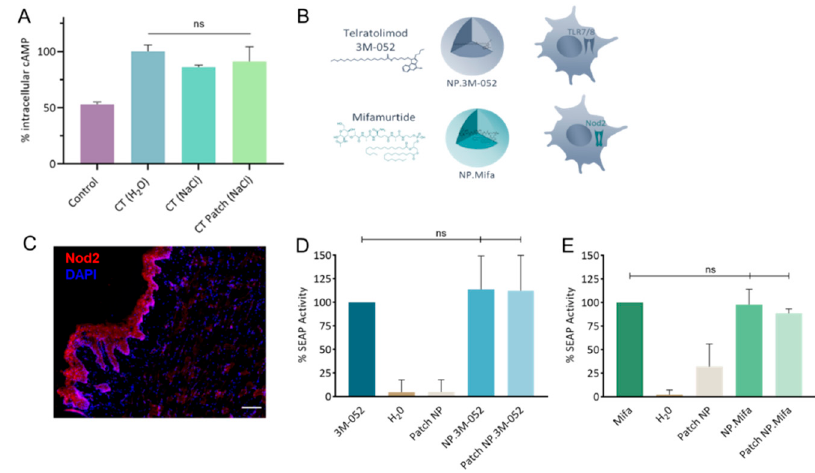
Figure 4. Bioactivity of mucosal adjuvants. ( A ) Quantification of intracellular cAMP produced after 24 h incubation of DC 2.4 cells with CT either formulated as a liquid solution (H 2 O or NaCl) or as an LbL patch in 0.15 mol/L NaCl. The percentage was normalized to the average amount of cAMP produced after contact with CT in H 2 O. ( B ) Schematics of 3M-052 and mifamurtide incorporated in PLA-NP and their respective immune receptors. ( C ) Staining of Nod2 receptors in the SL mucosa of mice. Nod2 receptors (red) and nuclei (DAPI, blue) were stained in naïve mice. Scale bar, 100 µ m. ( D , E ) Quantification of the SEAP produced after the activation of ( D ) HEK-Blue hTLR7 cells by 3M-052 formulations and ( E ) HEK-Blue hNOD2 cells by mifamurtide formulations, either in their free form, encapsulated in NP, or released from the LbL patch. Data are presented as mean ± SD and were statistically analyzed using one-way ANOVA followed by Tukey’s multiple comparison test (not significant (ns): p >